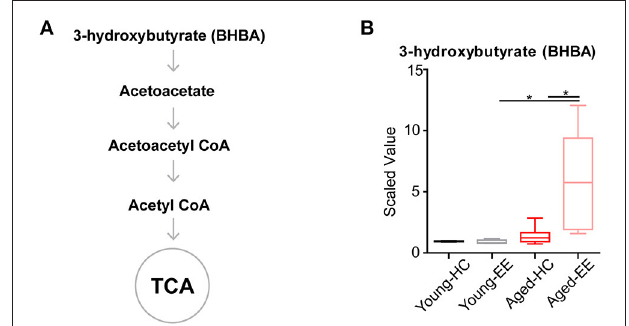
FIGURE 4 | Concentration of metabolites related to acetyl CoA of aged hippocampus. (A) Schematic drawing of metabolic pathway including ketone body metabolism linking with acetyl CoA. (B) Box plot of the levels of 3-hydroxybutyrate (BHBA) in young adult and aged mice. HC, n = 6; EE, n = 6; * p < 0.05; unpaired t